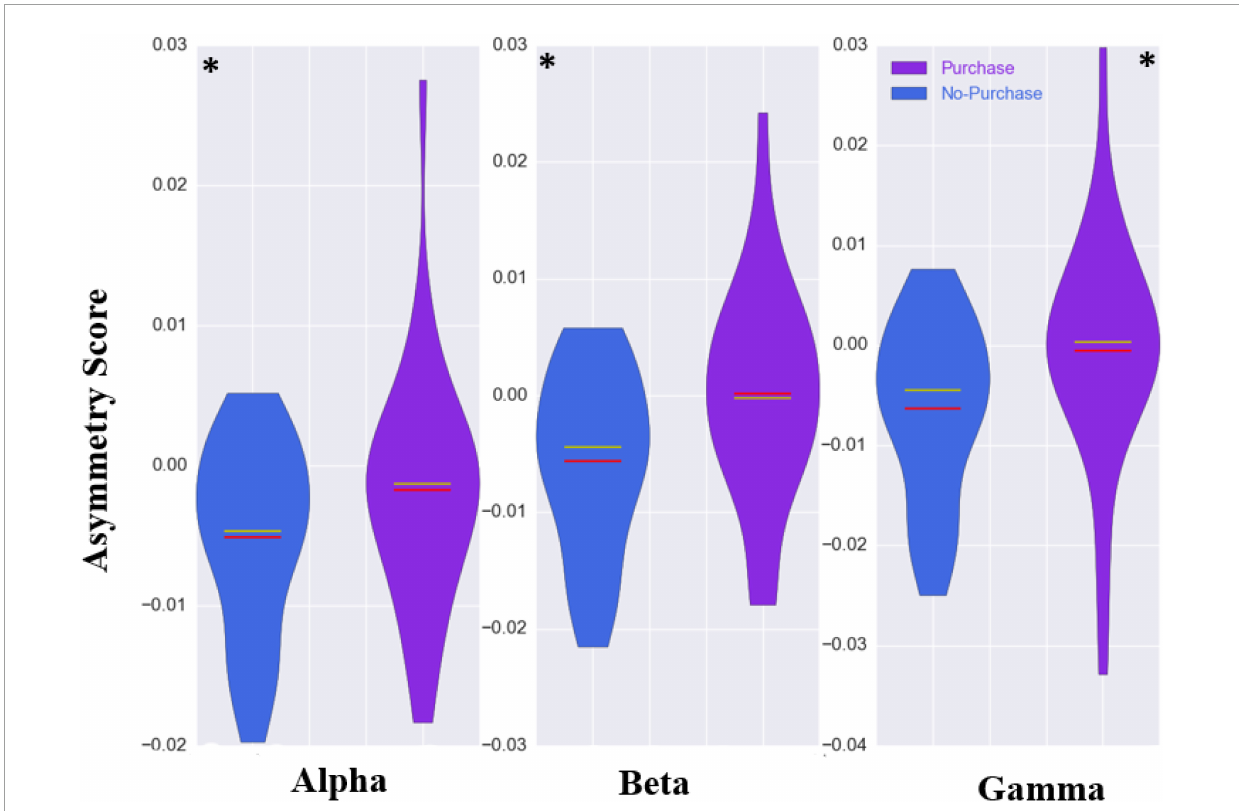
FIGURE4 The violin plots of asymmetry scores of three frequency bands for all subjects. The purchase and non-purchase conditions are shown with blue and purple colors, respectively. The red and yellow line in the middle illustrating the mean and median values, respectively. The difference between the asymmetry scores were statistically significant ( ∗ p -value < 0.001) in all tree frequency